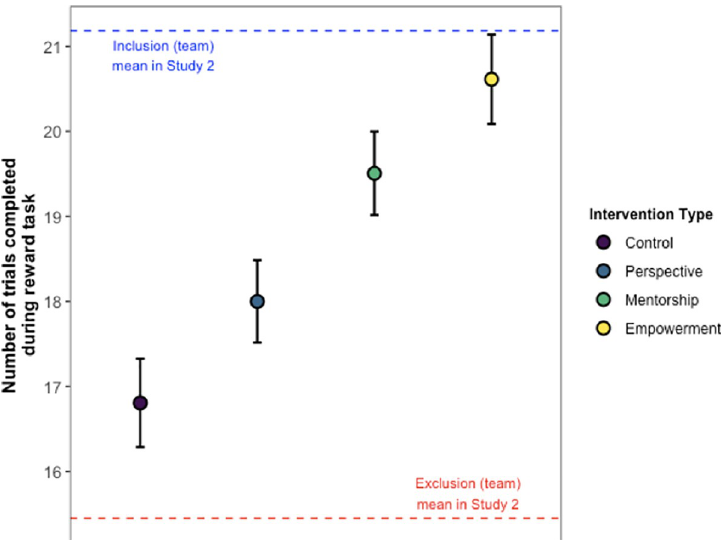
Fig 7. Main results from Study 4. The number of completed reward tasks is shown on the y -axis, and intervention conditions are color-coded. The blue dotted line shows the grand mean reward task completion for all inclusion participants in Study 2 that were earning rewards on behalf of their teams . The red dotted line shows the grand mean reward task completion for all exclusion participants in Study 2 that were earning rewards on behalf of their teams . Grand means for Study 2 inclusion and exclusion participants are shown as a reference, given the similarity in task design and reward structure. Error bars show ± 1